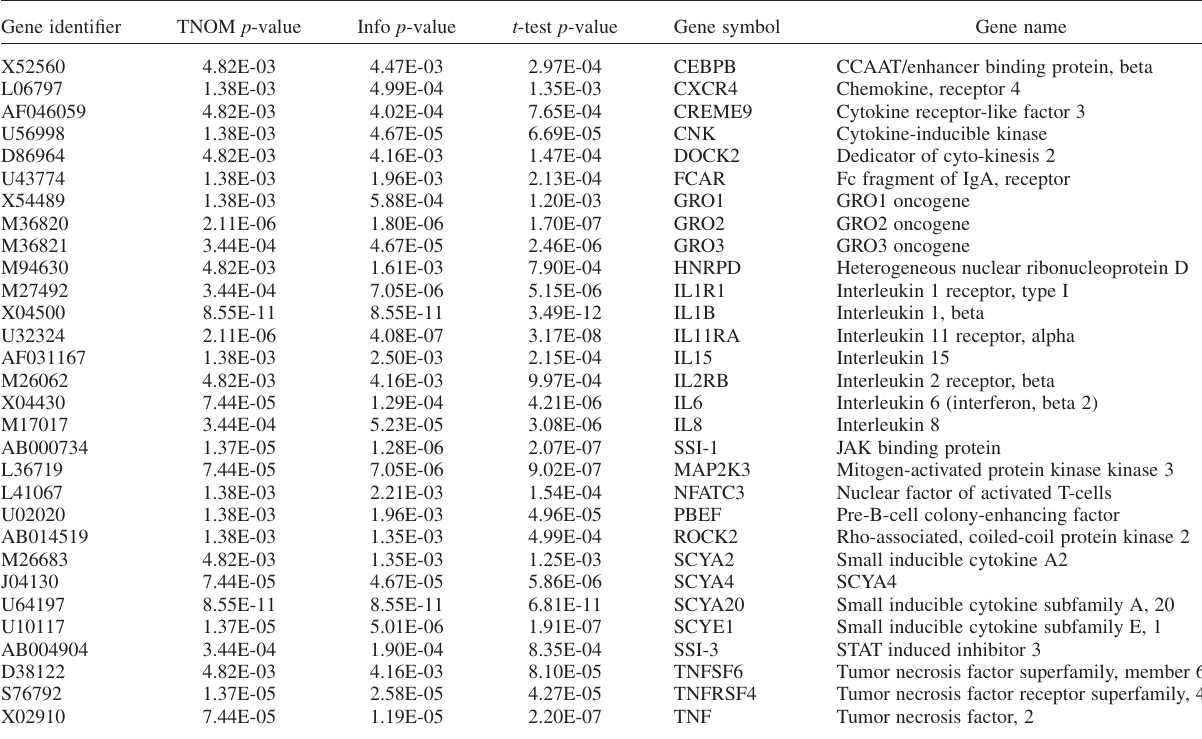
TABLE I List of 30 cytokine-related gene transcripts in the MS specific signature